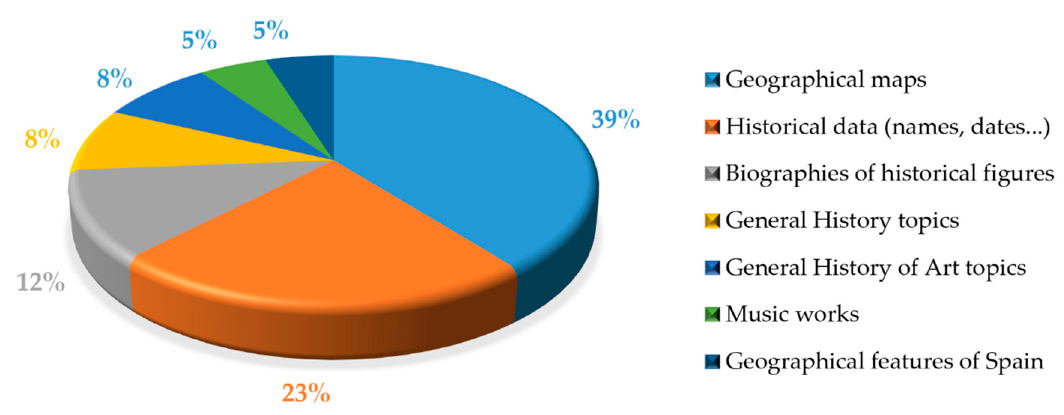
Figure 1. Typology of Social Sciences contents that generate greater difficulty for students.